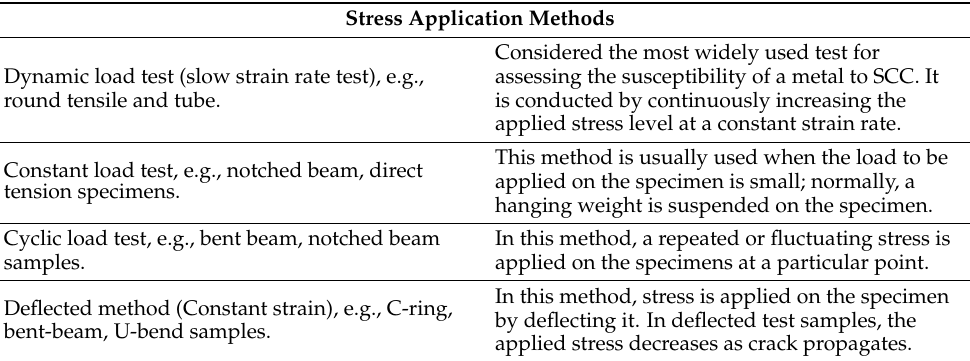
Table 4. Common stress application methods. Data from